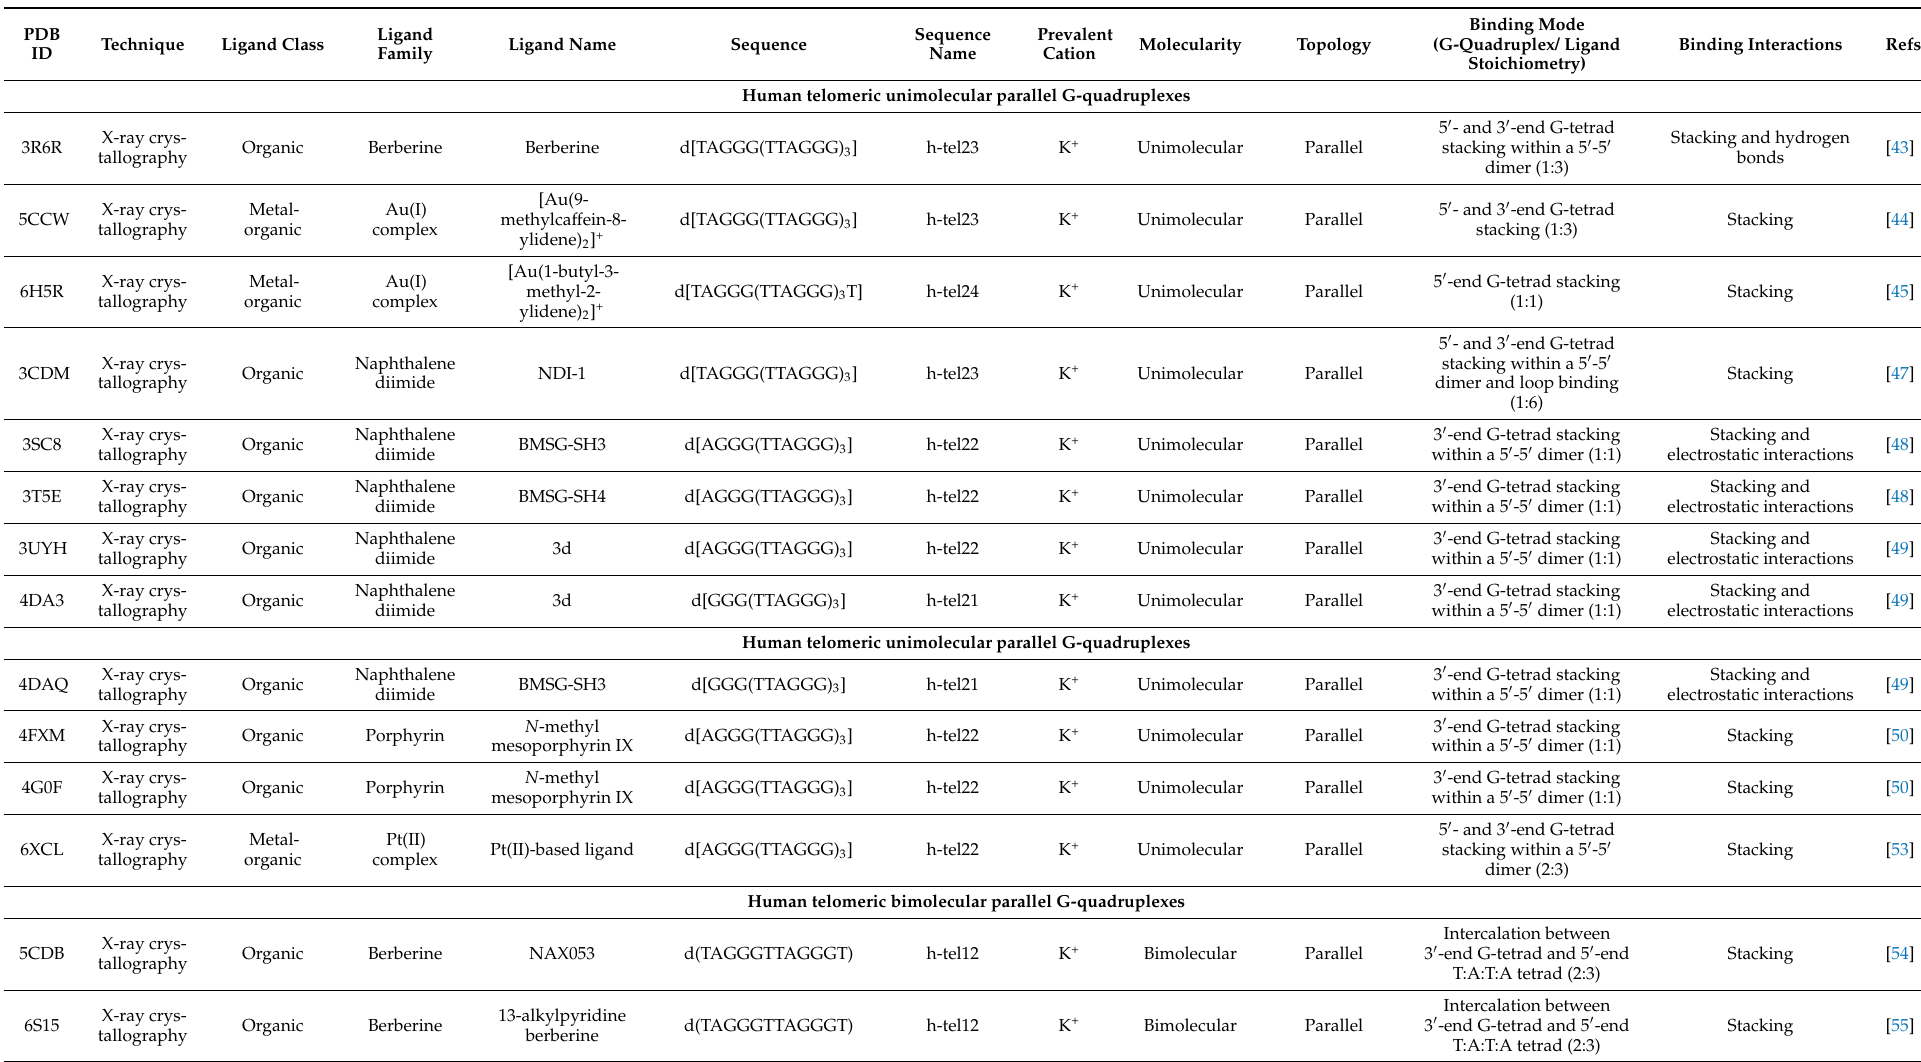
d(TAGGGTTAGGGT) h-tel12 K + Bimolecular Parallel